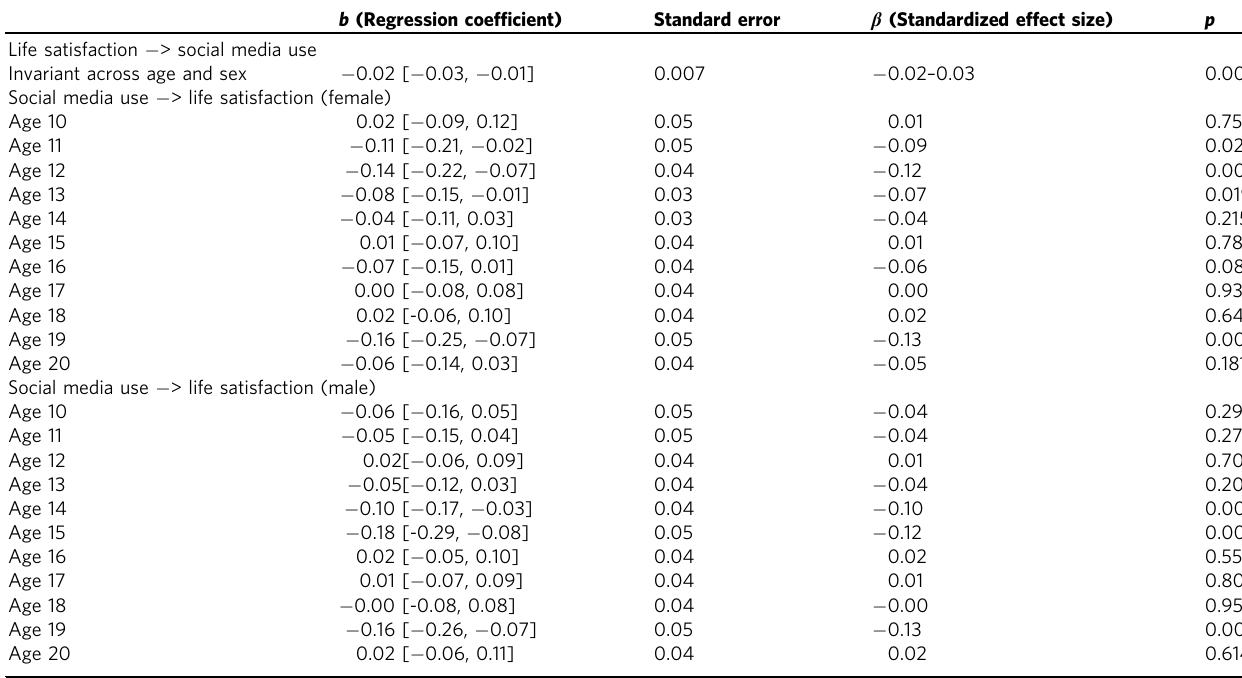
Table 1 Results of the best fi tting Random-Intercept Cross Lagged Panel Model examining the bidirectional links between life satisfaction and social media use across ages 10 – 21